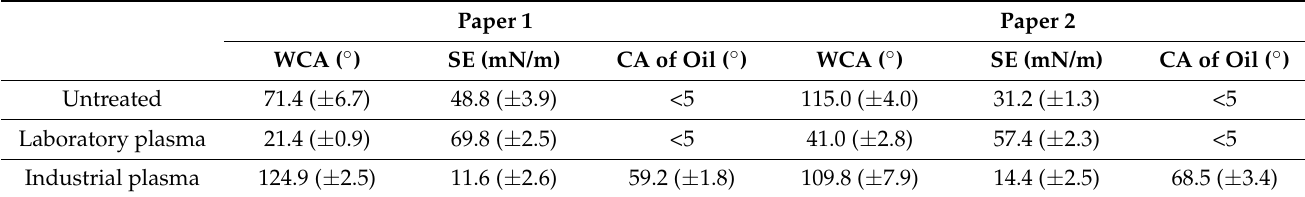
Table 1. The results of water contact angles and surface energy measurements of paper 1 and 2 in untreated state and immediately after plasma coating treatment in laboratory and industrial reactor. Paper